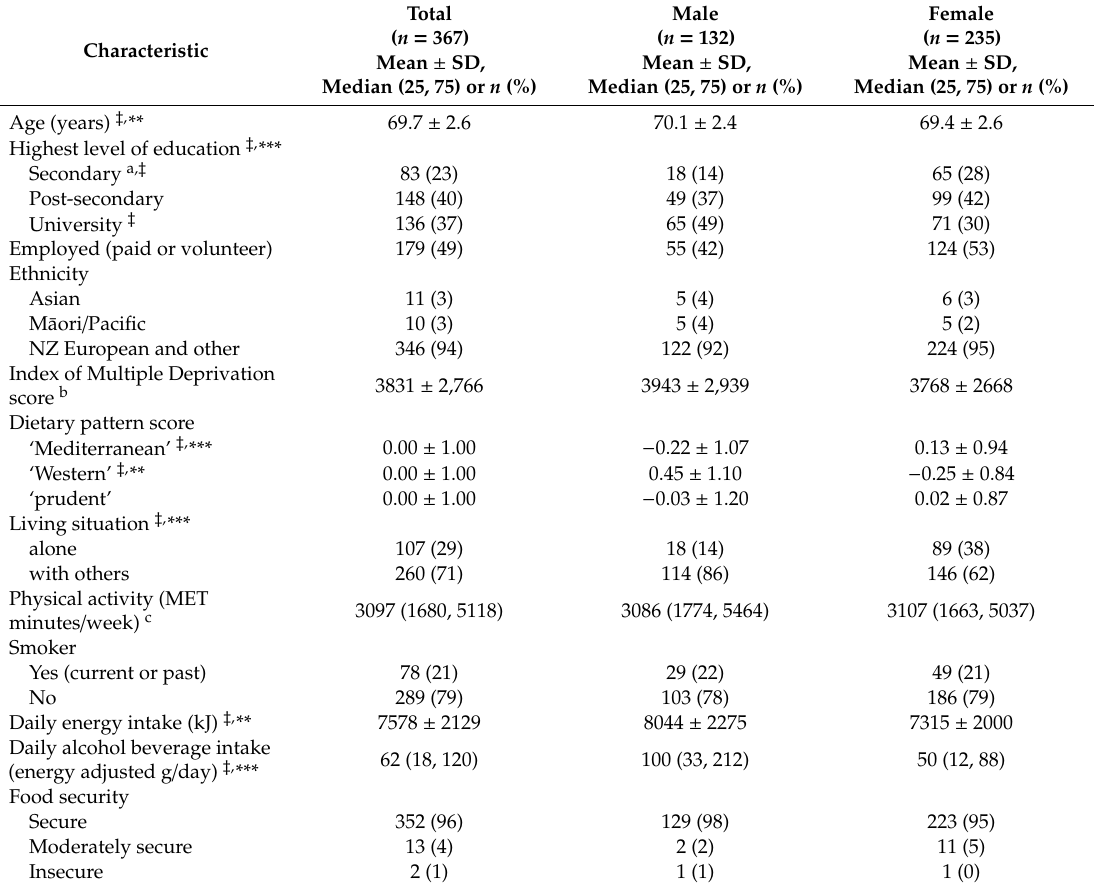
Table 2. Participant